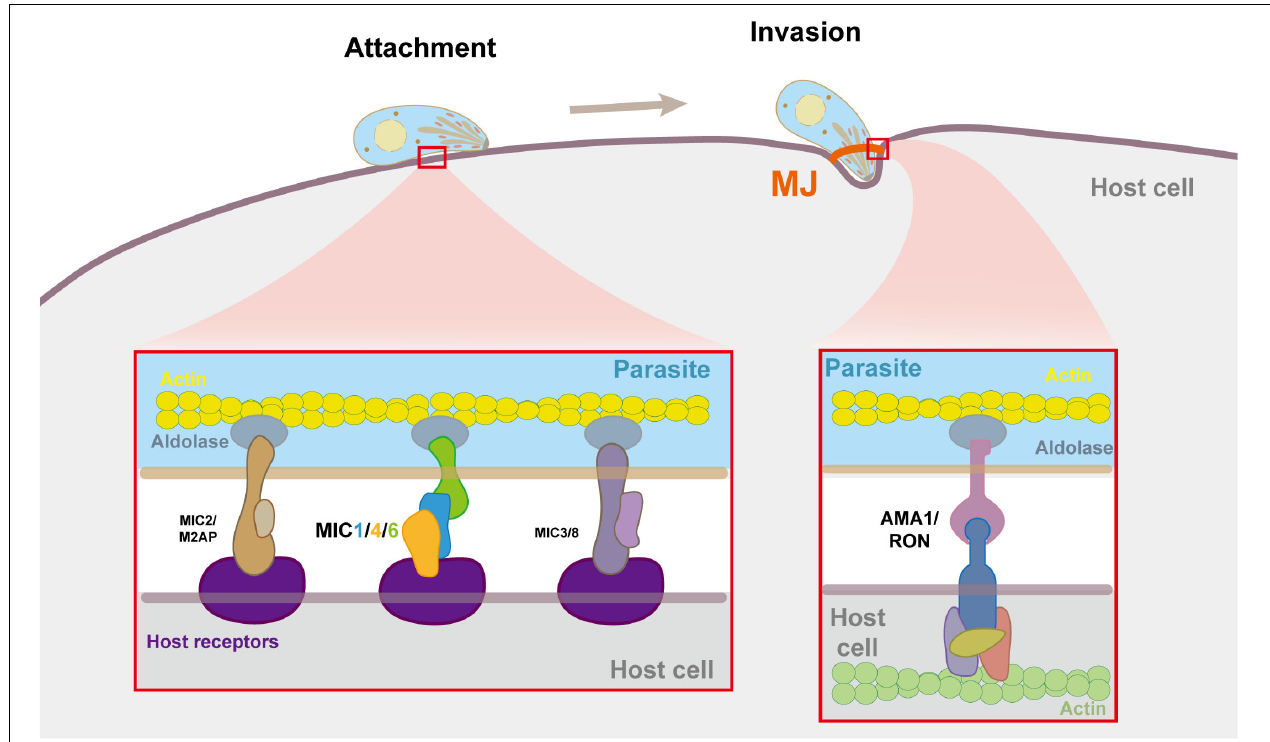
FIGURE 3 | Molecular details of microneme complexes formated during host cell adhension and invasion by T. gondii. In the process of adhesion and invasion, MICs and RONs are secreted by the parasites, and form multiple multi-molecular complexes on the parasite and the host cell plasma membrane to bind them tightly, thereby triggering cell invasion. The enlarged image shows the detailed molecule interactions at the moving junction (MJ). MICs bind to receptors on the host cell surface. The AMA1-RON2 interaction forms MJ which anchors the parasite to the actin cytoskeleton of the host cell. Within the parasite pellicle, MICs bind to aldolase, which connects the complex to the parasite’s